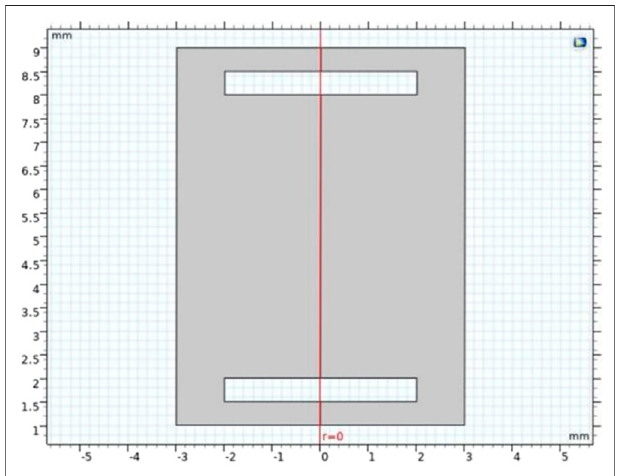
FIGURE 1 | 2D structure of gas discharge model.